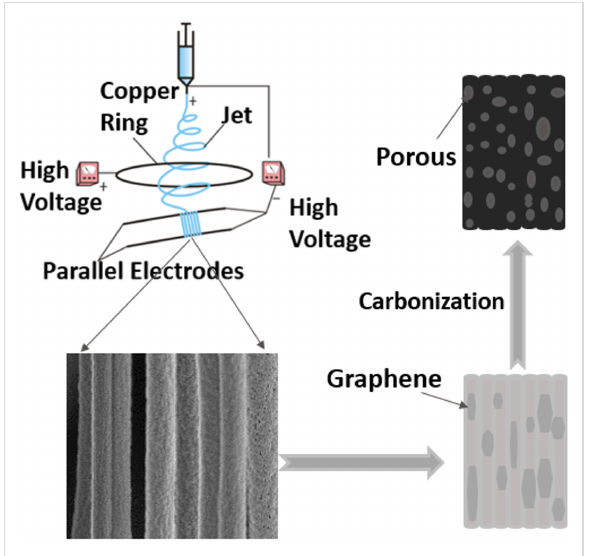
Figure 1: Diagram of the preparation process of the ordered porous CGCNFs. Setup scheme adapted from [33], distributed under the terms and conditions of the Creative Commons Attribution (CC BY) license (http://creativecommons.org/licenses/by/4.0/).